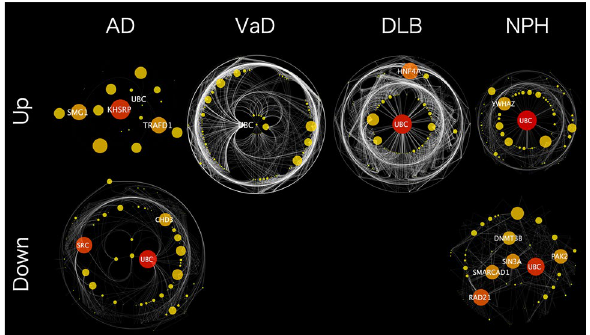
Figure 3. PPI network analysis for the genes that were targeted by the miRNAs. The gene symbol is displayed for nodes with degree > 100.